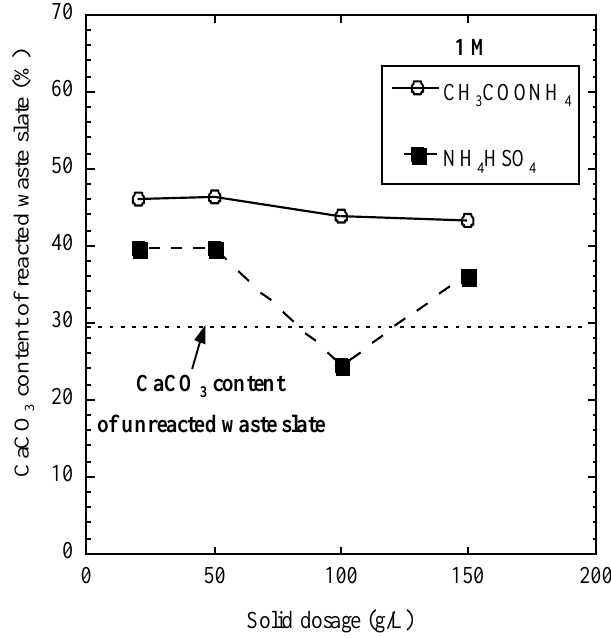
Figure 7. CaCO content of reacted waste slate samples determined using TGA as a 3 function of the solid dosage with the 1.0 M CH COONH and NH HSO solutions. 3 4 4 4 After the carbonation tests using 1 M CH COONH and 1 M NH HSO solutions, the calcite peak 3 4 4 4 intensity increased at all the solid dosages (Figure 8). For both 1 M CH COONH and 1 M NH HSO 3 4 4 4 solutions, a chrysotile peak was still observed in the reacted materials after the carbonation tests. For the 1 M CH COONH and 1 M NH HSO solutions, almost similar XRD results were obtained, except 3 4 4 4 for the formation of gypsum (CaSO ·2H O) for the 1 M NH HSO solution (Figure 8). 4 2 4 4